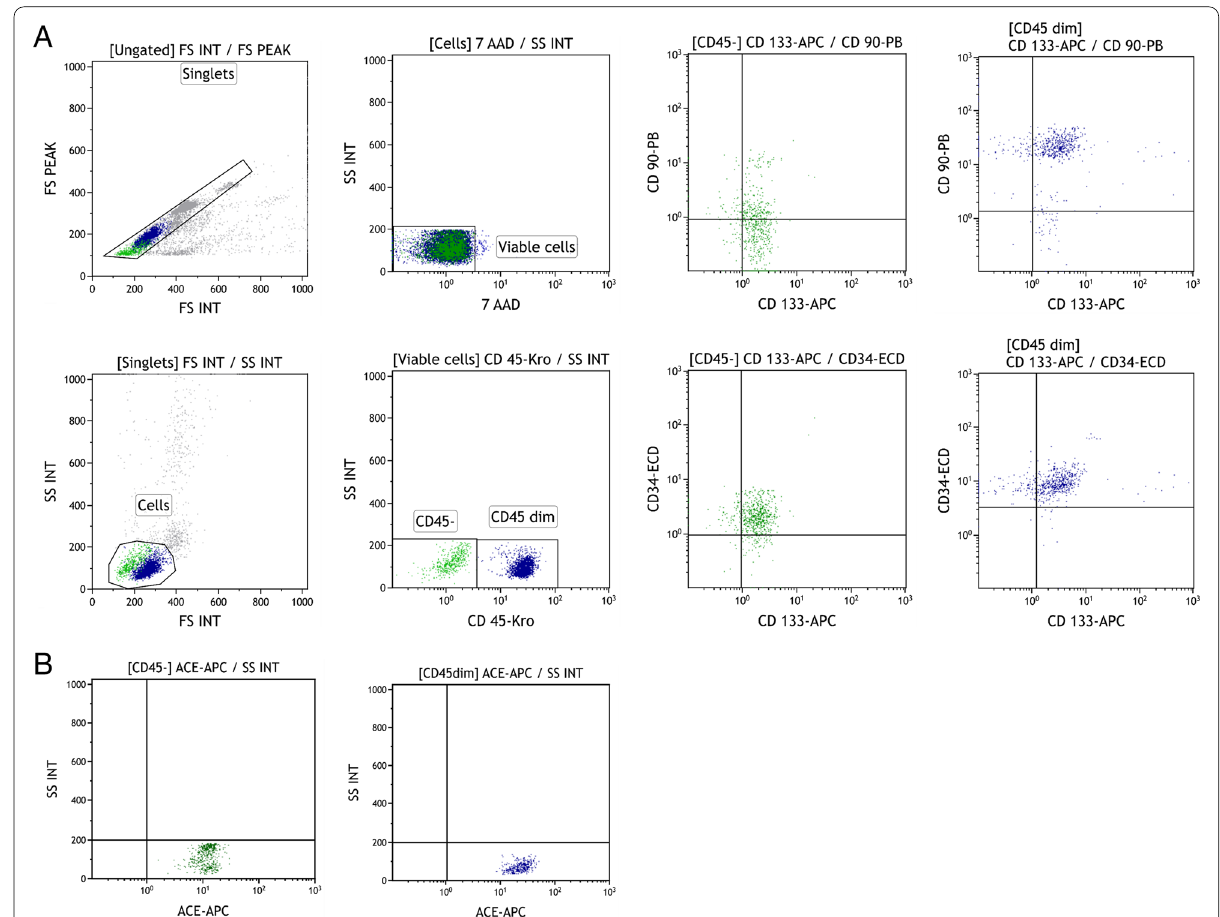
Fig. 2 Flow cytometry gating strategy. Legend: Immunophenotype characterization of peripheral blood non‑hematopoietic enriched stem cell cocktail. 2A) Logic and manual gating strategy for cell characterization using five monoclonal antibody‑conjugated CD markers